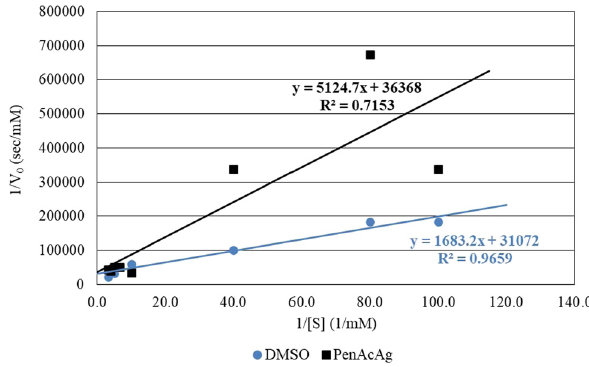
Figure 13: Graphical plotting for determination of K m and V max using Lineweaver – Burk coordinates for PenAcAg